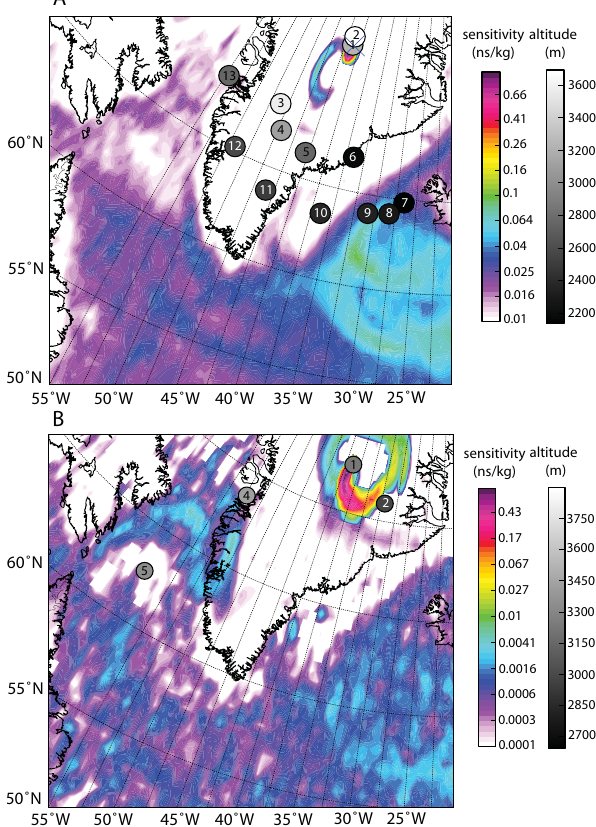
Fig. 4. Footprint emissions sensitivity for the period of 10 (A) and 12 (B) June 2008, 00:00–03:00UTC, using the nested model output (0.5 ◦ ). The release location (Summit Station) is marked with an “X”. The retroplume centroid locations for each day back are shown as gray circles, where the shade of gray is scaled to elevation. On 10 June 2008, days 1, 2, and 3 are clearly located over the Greenland ice sheet. On 12 June 2008 only days 1 and 2 are visible, with day 3 being further north over the Greenland Ice Sheet. Note the enhanced sensitivity in the lowest model layer recirculating around